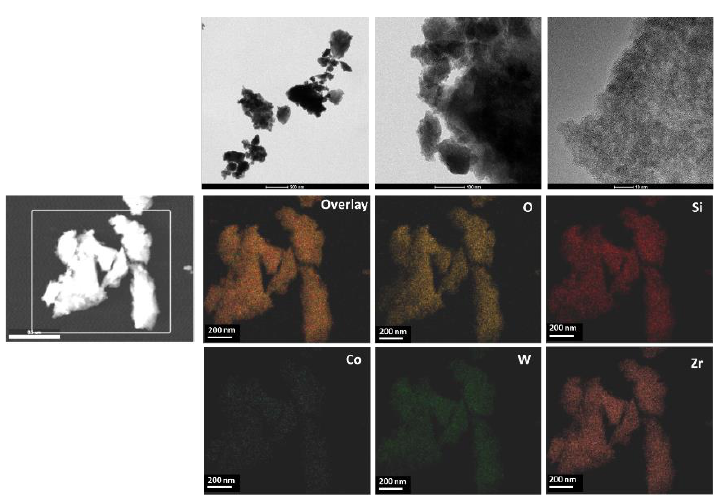
Figure 4. TEM and Elemental mapping of Co/TSA – ZrO 2.